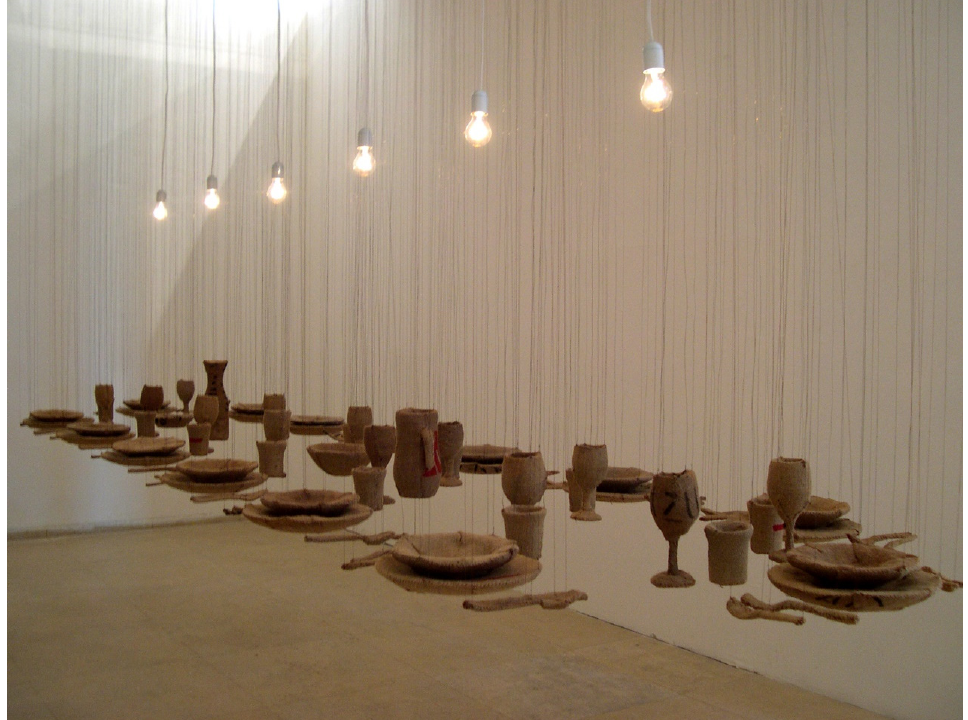
Figure 2. Dvora Morag, “A Set Table”, 2005. Installation. Photo: Avi